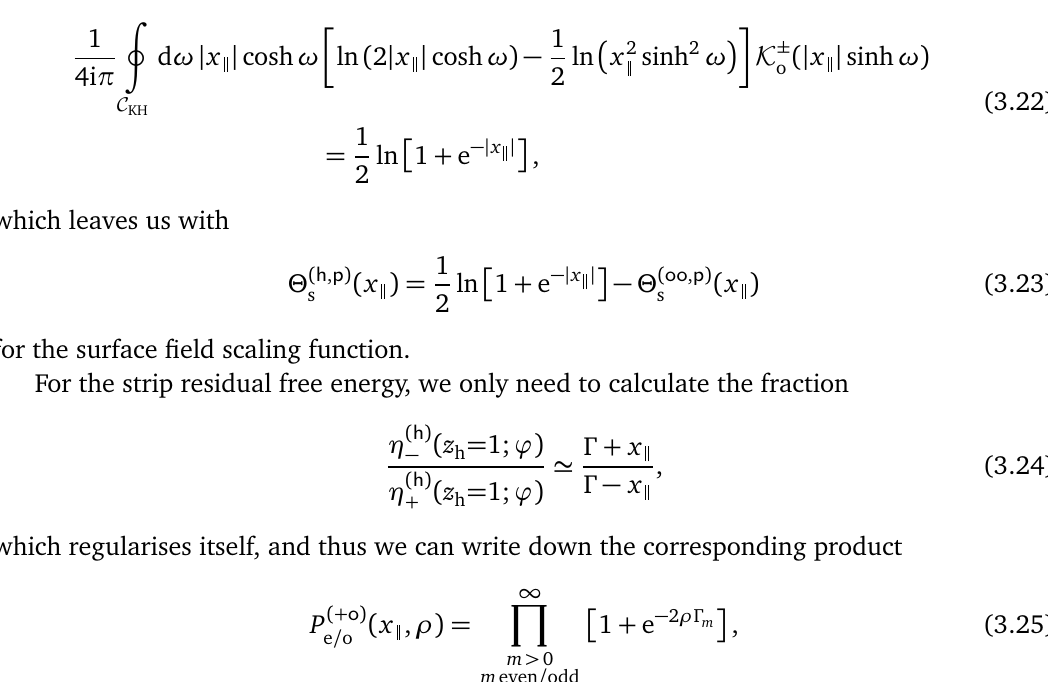
Figure 13: Scaling function Θ ρ ≤ 1. The scaling function converges rather fast agains its limiting case (3.29) and changes its sign for ρ ≈ 1 depending on the